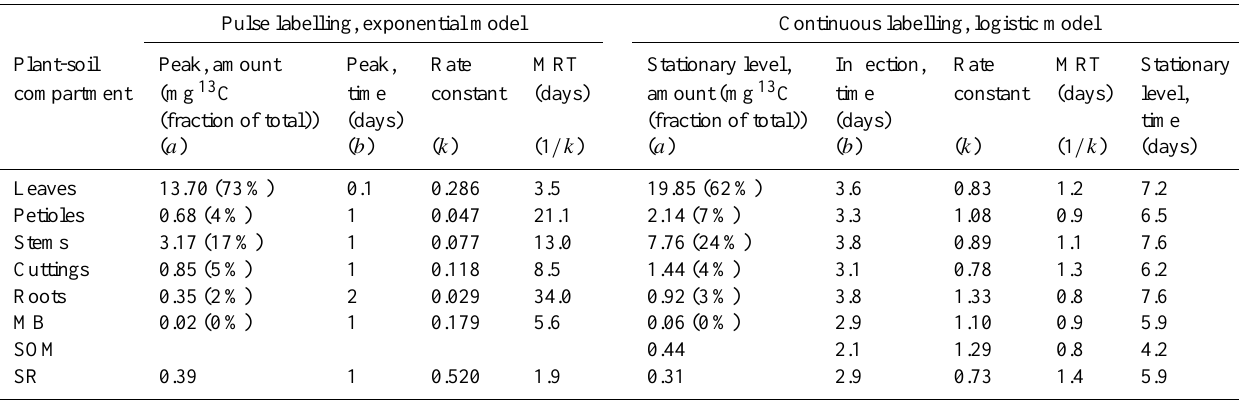
Table 2. Parameters ( a , b , k ) of the exponential and the logistic model used to describe the 13 C dynamics in the pulse (PL) and continuous (CL) labelling, respectively. Parameter a is the total amount of 13 C (mg) at the signal peak (PL) or at the stationary level (CL), parameter b marks the time of the signal peak (PL) or the time of inflection (CL) and parameter k is the rate constant describing the decrease (PL) and increase (CL) of the 13 C abundance in a compartment, which is the basis for the mean residence time (MRT) calculation.